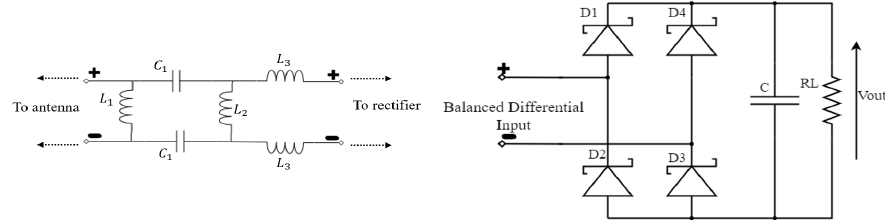
Figure 5. Voltage dual-DR architecture composed of four Schottky diodes and connected to the output RC circuit. On the left is the matching circuit, and on the right is the voltage doubler